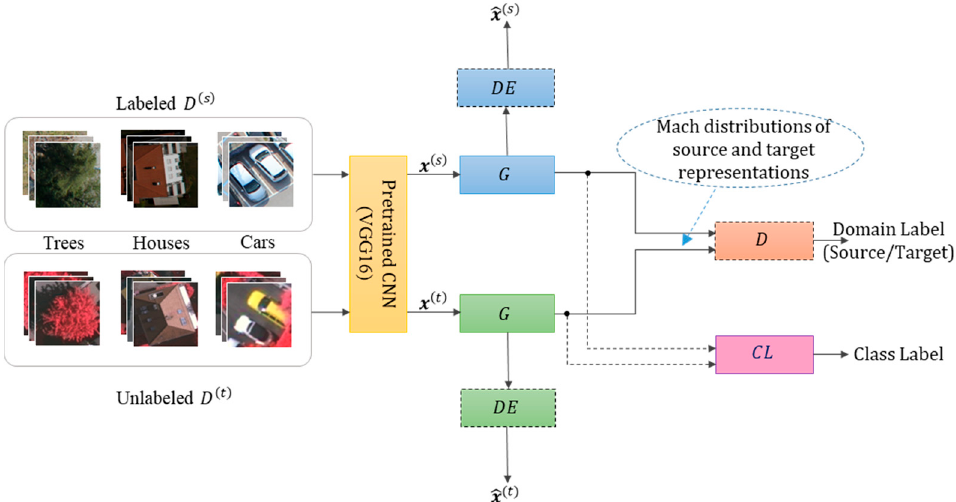
Figure 3. Proposed Siamese-GAN method.